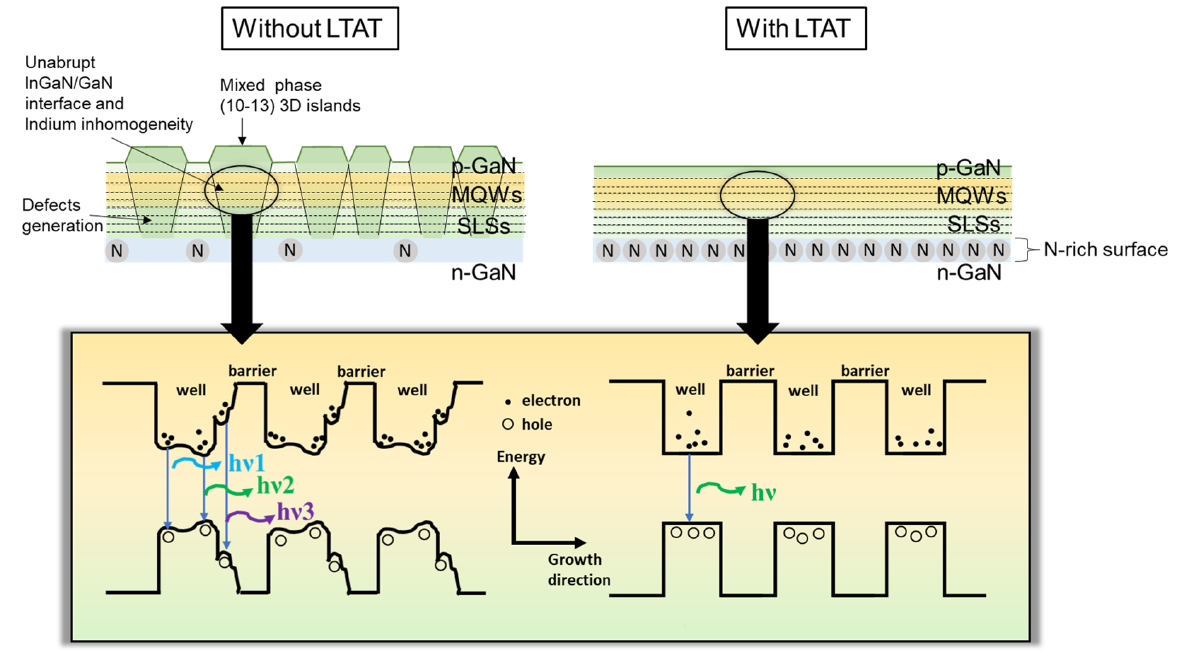
Figure 5. Illustration of the proposed mechanism for LTAT.